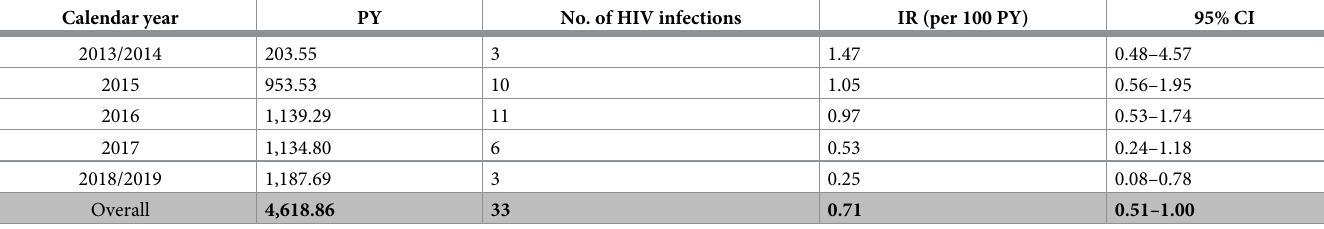
Table 2. HIV incidence among GBMSM participating in the AURAH2 prospective study,